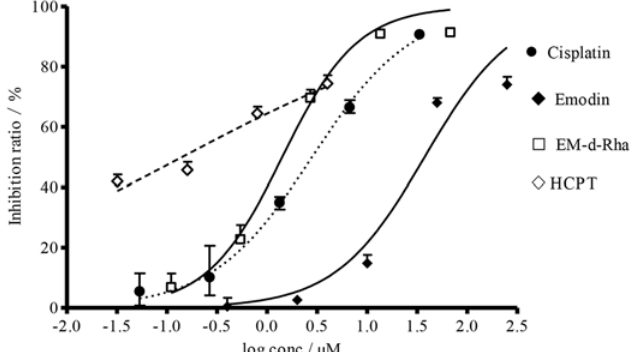
Fig 3. Dose-response curves of various compounds when HepG2 cells were treated for three day. Four curves represent the dose-response curve of HCPT, EM-d-Rha, Cisplatin, and Emodin against HepG2 cell from left to right in turn. The error bars represent mean ± standard deviation (three replicates). The horizontal axis represents the log concentration of EM-d-Rha, the vertical axis represents the inhibition